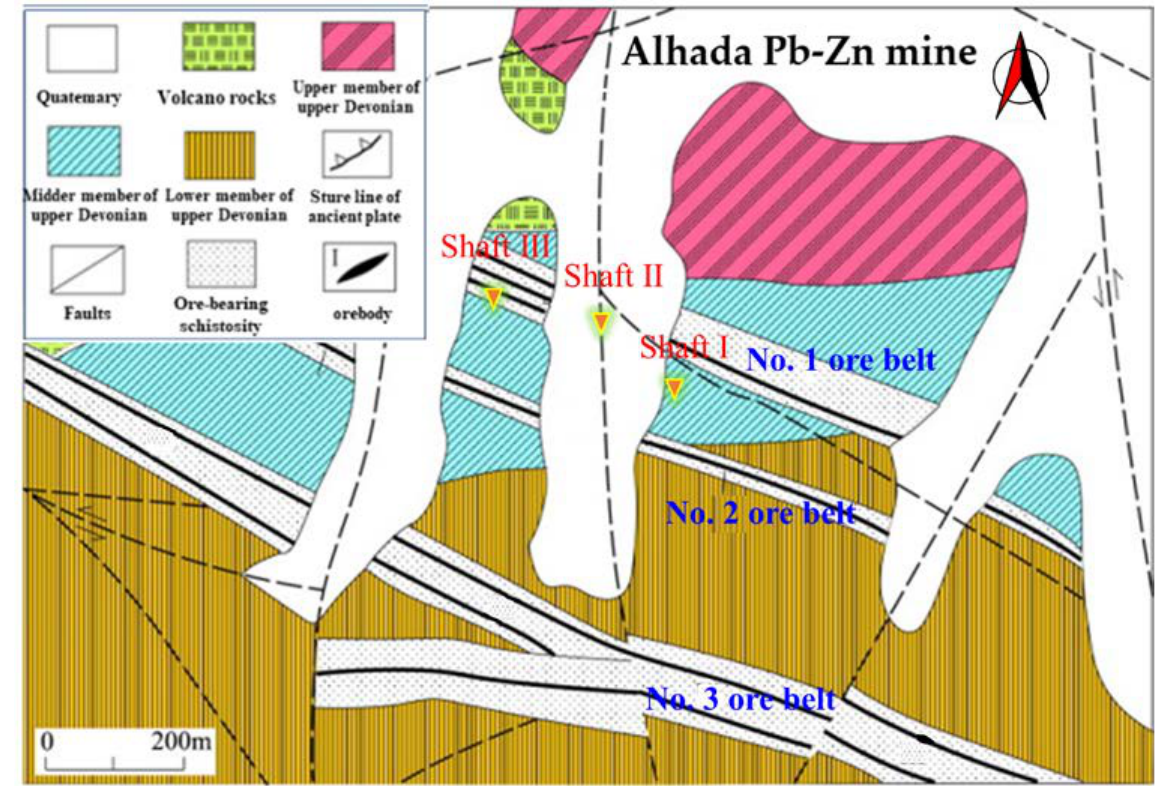
Figure 2. Distribution map of the vein of Alhada Pb-Zn mine [40] .